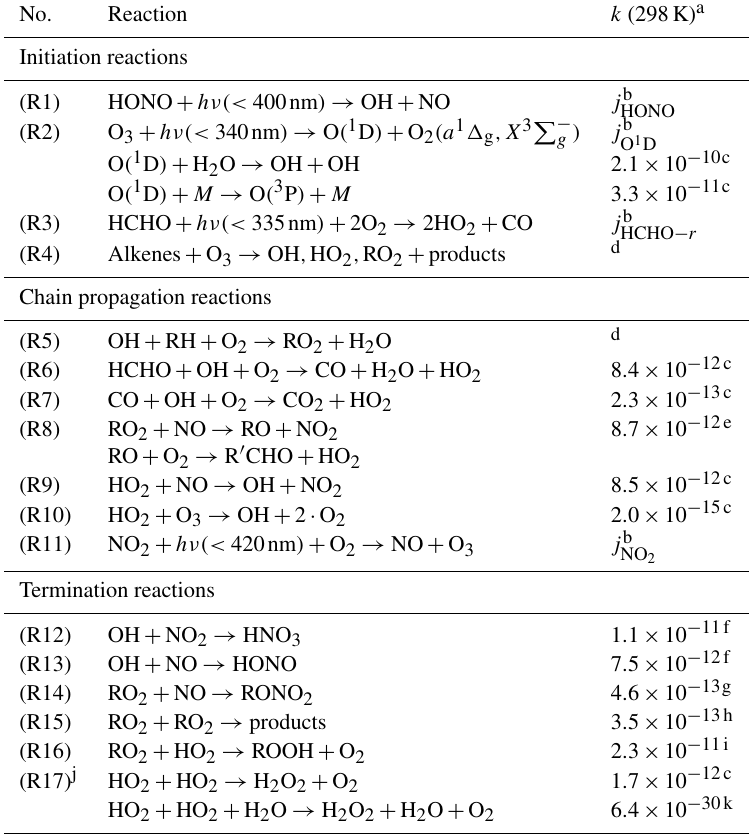
Table 1. Chemical reactions considered in the radical budget analysis of OH, HO 2 , and RO 2 . The radical species are cyclically linked by chain reactions. No. Reaction k (298K) a Initiation reactions (R1) HONO + hν(< 400nm ) → OH + NO j b